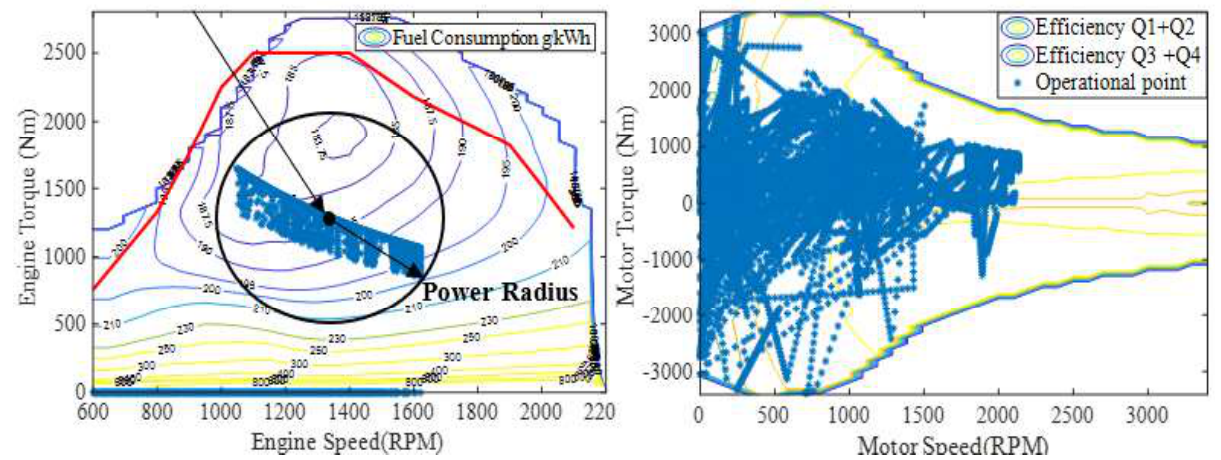
Figure 10. ( Left ): 600 hp, 15 L GEM fuel map restricted to MP8 operating range and power radius. ( Right ): TM4 motor efficiency map.